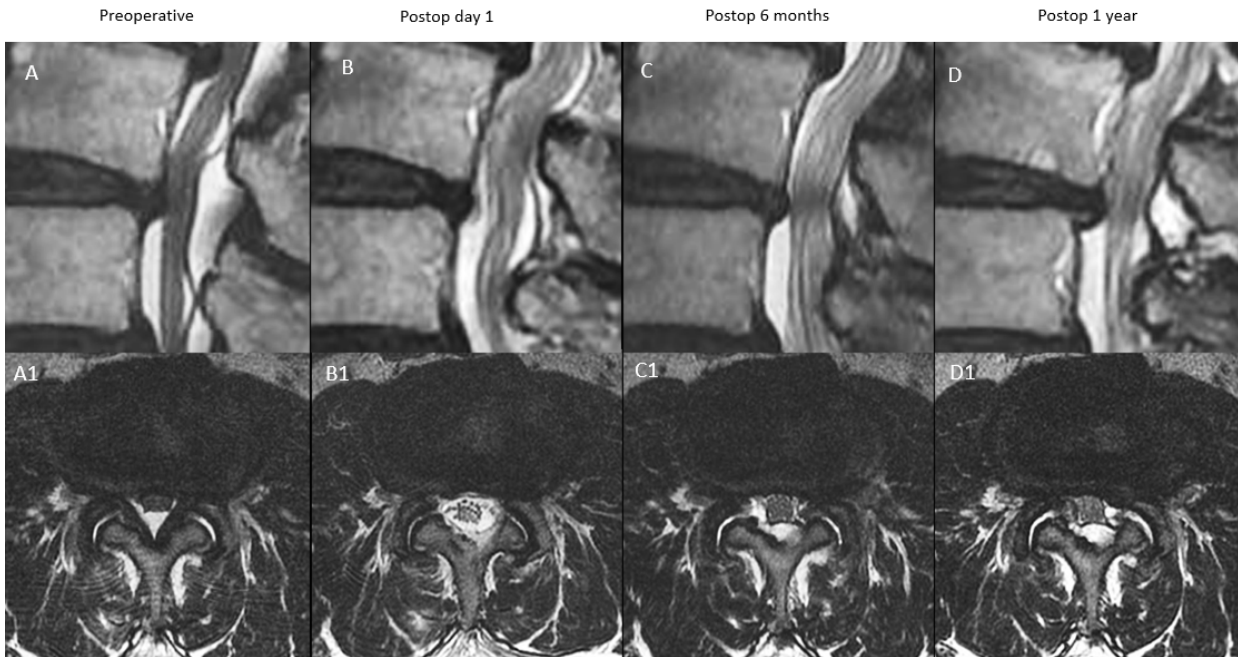
Figure 7. MRI appearance of remodeling patterns at preoperative, postoperative day 1, postoperative 6 months and postoperative 1 year with mid-sagittal cut in the top row and corresponding axial cut in the bottom row. Type D: remodeling type, preoperative spinal stenosis ( A , A1 ) with increased spinal canal area on postoperative day one MRI ( B , B1 ). There was moderate restenosis that occurred at postoperative 6 months ( C , C1 ), which improved modestly at postoperative one year with overall still significant moderate stenosis of the spinal canal ( D , D1 ). Table 1. Description of the types of remodeling patterns and corresponding spinal canal area measurement at postoperative day one, 6 months and one year.